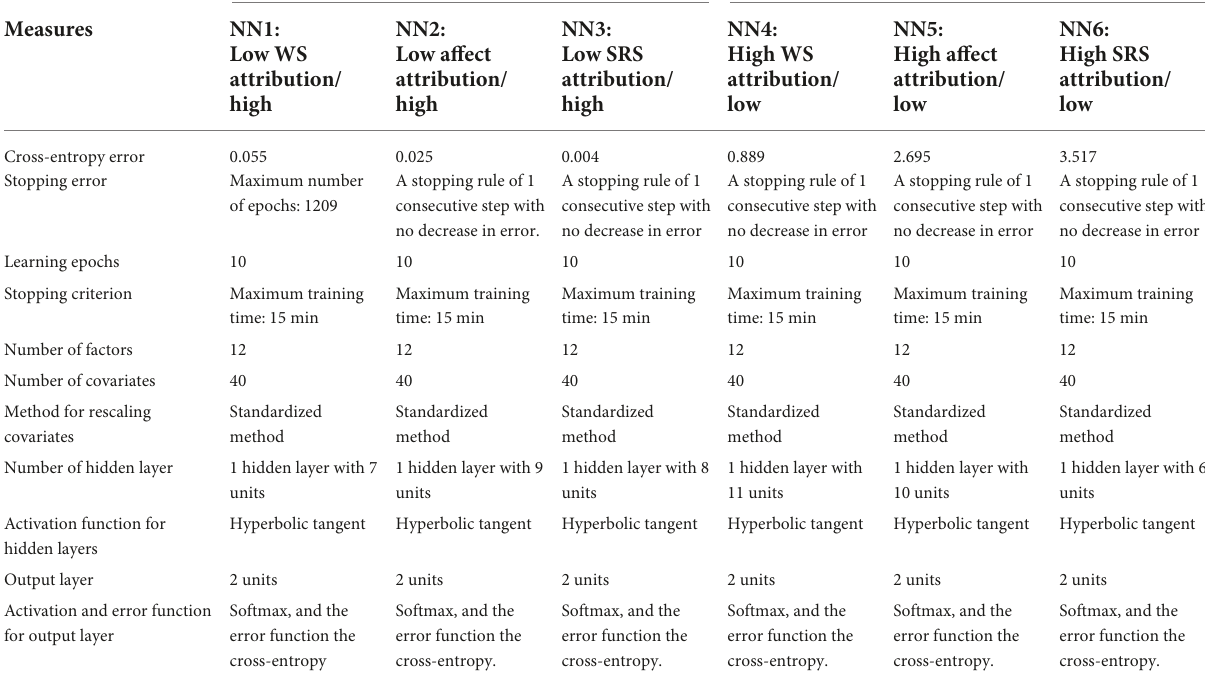
TABLE 1 Architecture of NN models